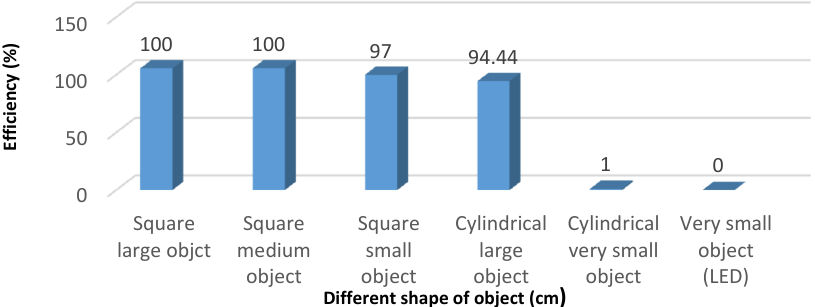
Fig. 14 Graph of different response of ultrasonic sensor against different shape and size of